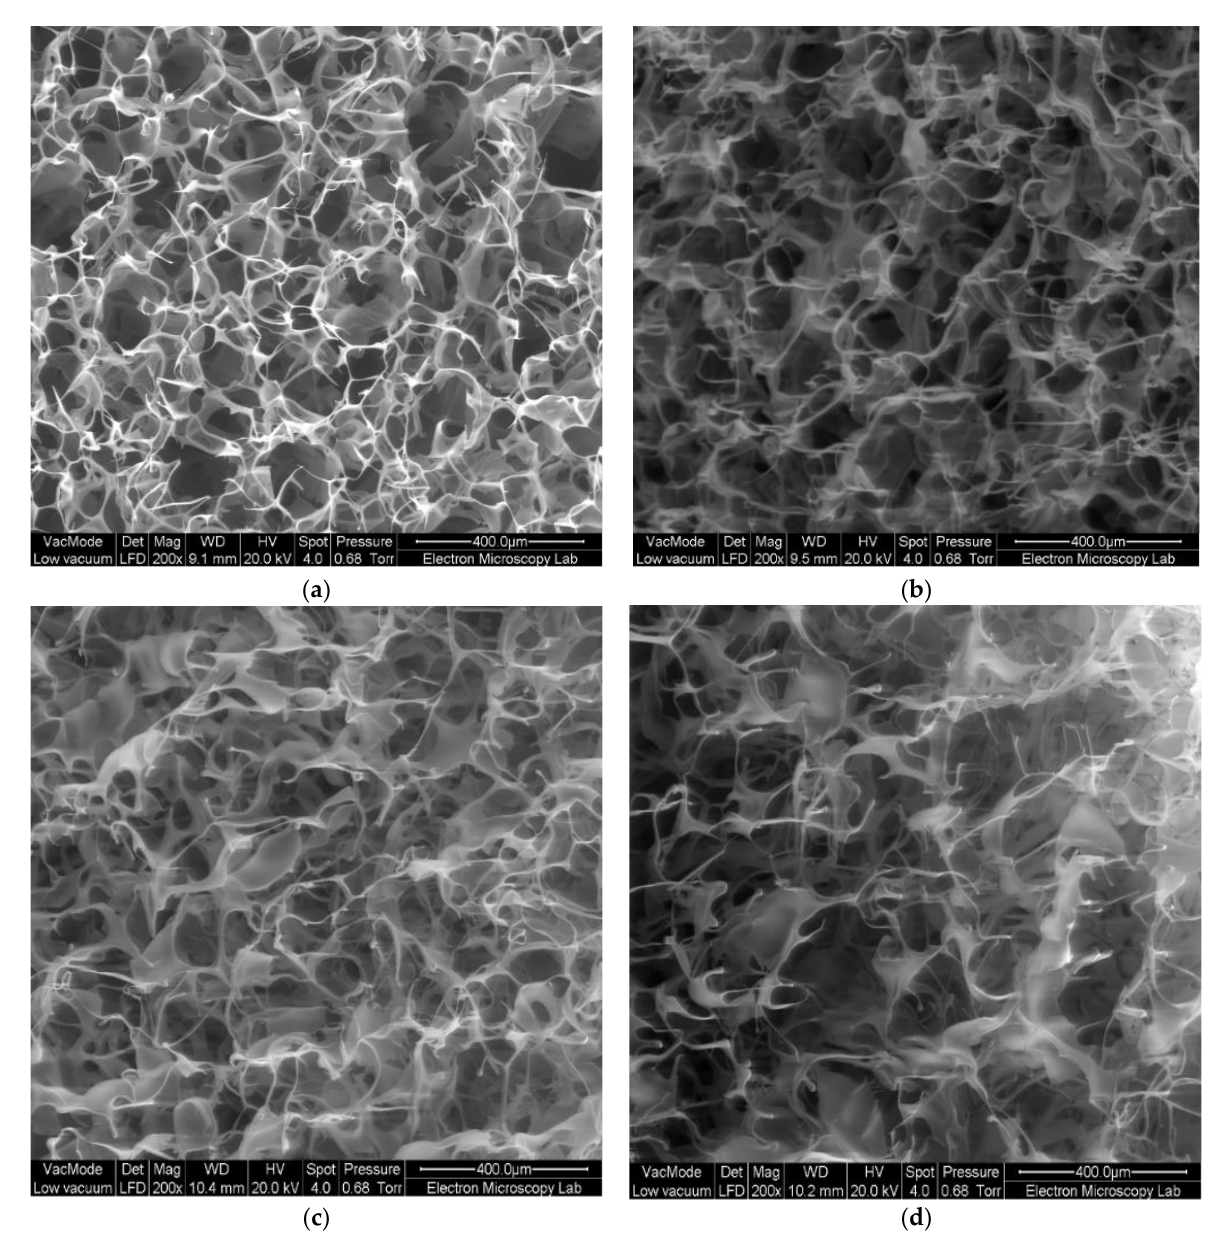
Figure 7. SEM images of lyophilised wafers of ( a ) unmodified HEC, ( b ) HECGMA Low, ( c ) HECGMA Medium and ( d ) HECGMA High.